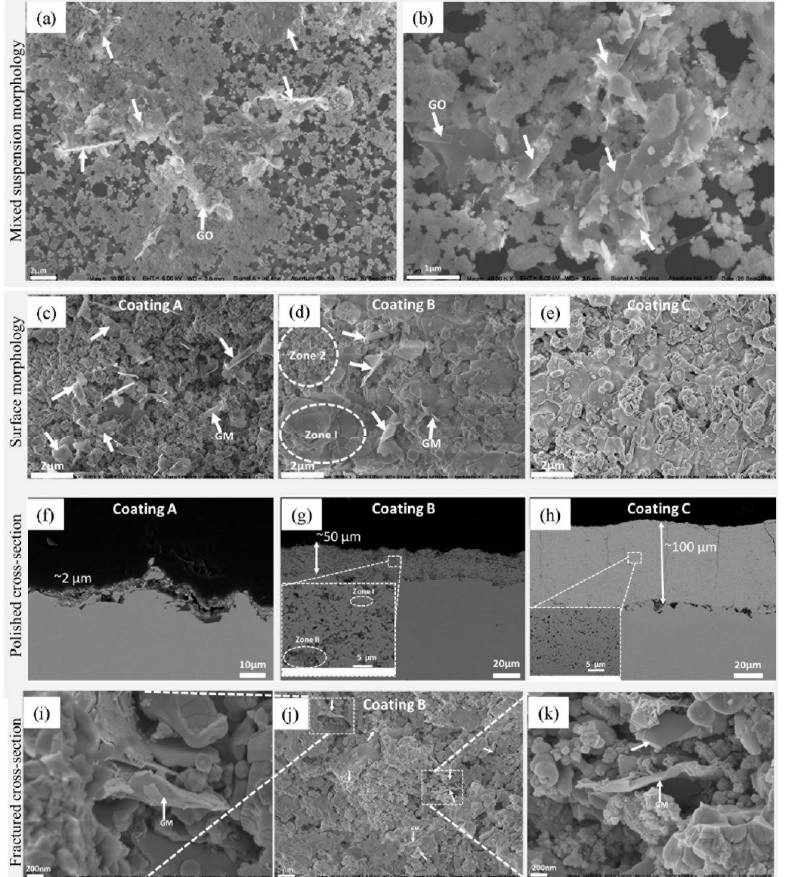
Figure 2. Scanning electron microscopy (SEM) micrographs revealing the 8 wt.% yttria-stabilized-zirconia-graphenaceous (8YSZ-GM) morphology in the mixed suspension ( a , b ), the morphology of the top surface of the coatings ( c – e ), the microstructures of the polished cross-sections of the coatings ( f – h ), and the fractured cross-section of Coating B ( i – k ) .